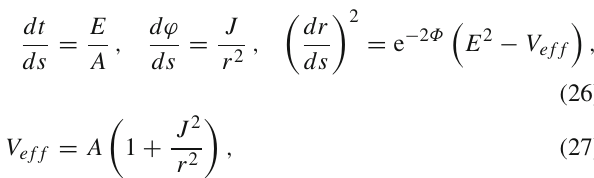
Fig. 1 The left panel shows the function ξ( r ) given by (29); SFNSs andSFBHshavemassesintheintervals ( 0 ,ξ( 0 )) and (ξ( 0 ), ∞ ) ,respec- tively. The middle panel shows the metric functions A ( r ) for the SFNS (30) with a = 3 and for the Schwarzschild solution of the same mass